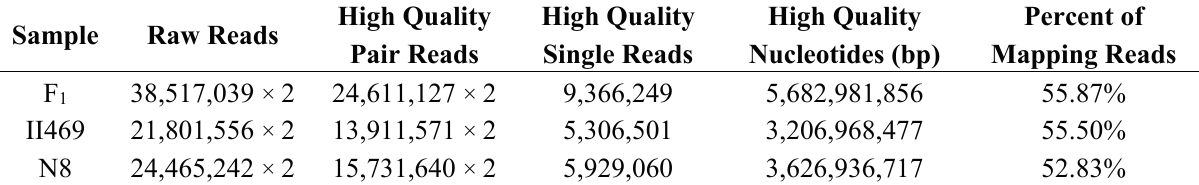
Table 1. Statistics of trimmed reads and percent of mapping